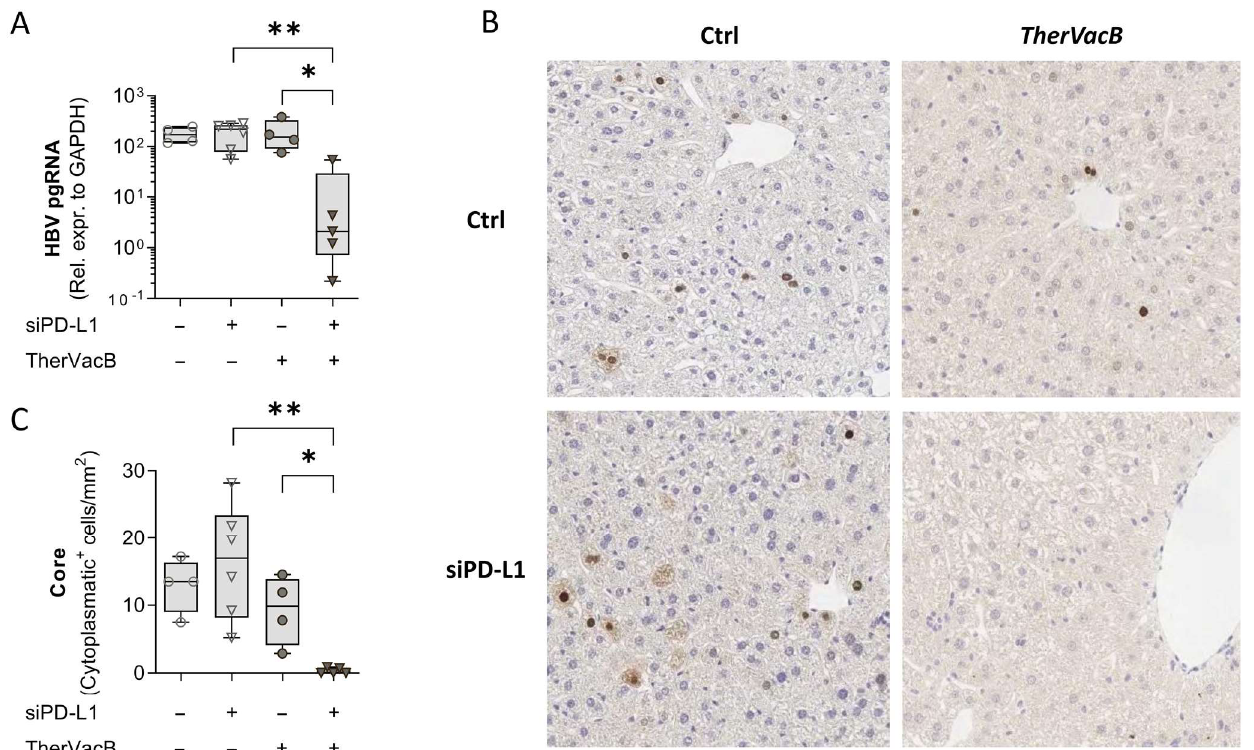
Figure 3. Effect of TherVacB and siPD-L1 on HBV persistence in the liver. ( A ) HBV pregenomic RNA (pgRNA) was quantified in liver lysates by RT-qPCR. ( B , C ) Quantification of hepatocytes that stained positive for HBc using immunohistochemistry. ( B ) One representative staining per group is shown. ( C ) Box plots show median, interquartile ratio (IQR) (box), and minimum to maximum (whiskers) numbers of cells with HBc + cytoplasm per animal. ( A , C ) Data from four to six animals per group are shown. Kruskal–Wallis with Dunn’s multiple comparison correction; * p < 0.05, ** p < 0.01.